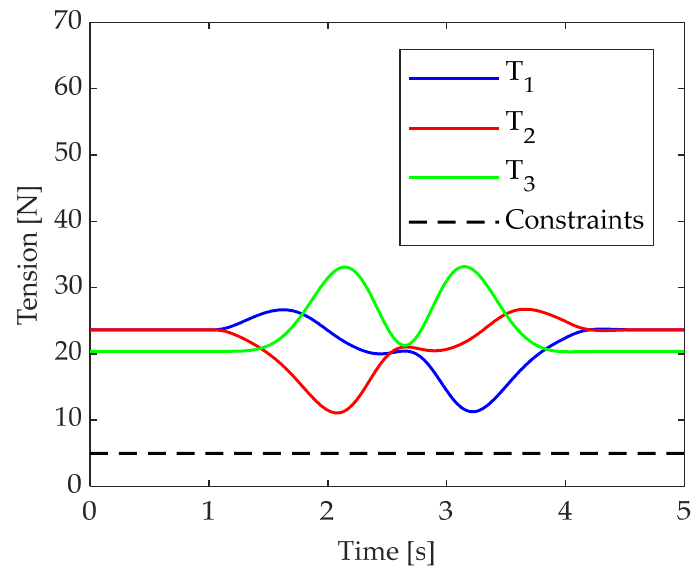
Figure 7. Cable tensions in the execution of the circular path.